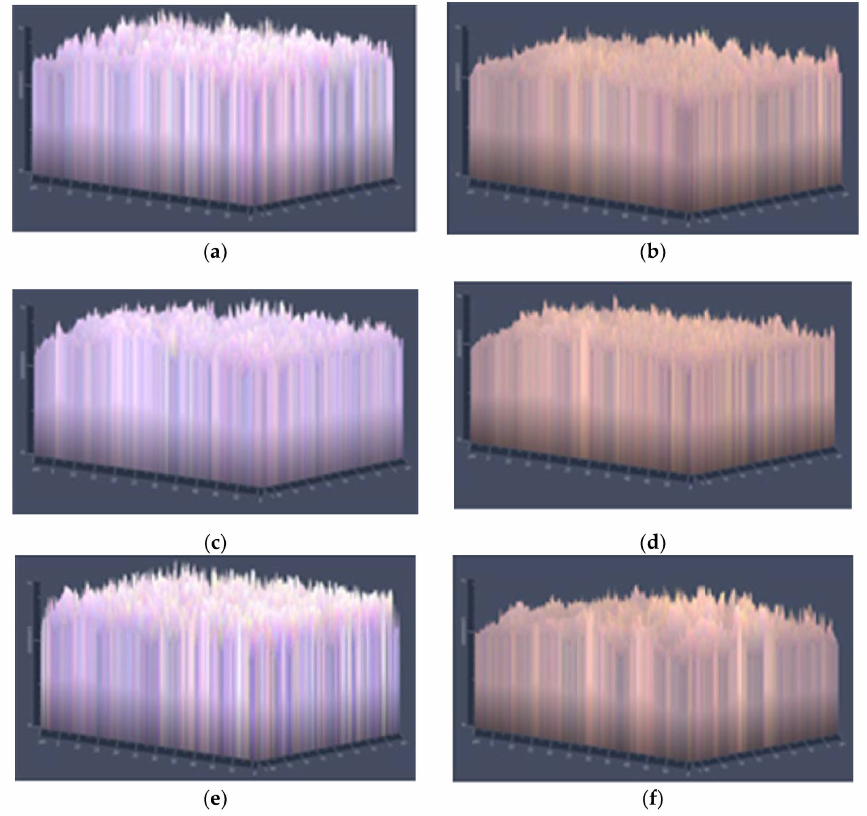
Figure 2. Optical micrographs of the films surface relief at 40 × of films: ( a ) F1, ( b ) F2, ( c ) F3, ( d ) F4, ( e ) F5 and ( f )